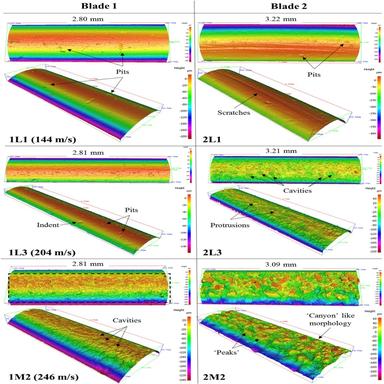
3D profiles of L1, L3 and M2 zones of both leading edges.